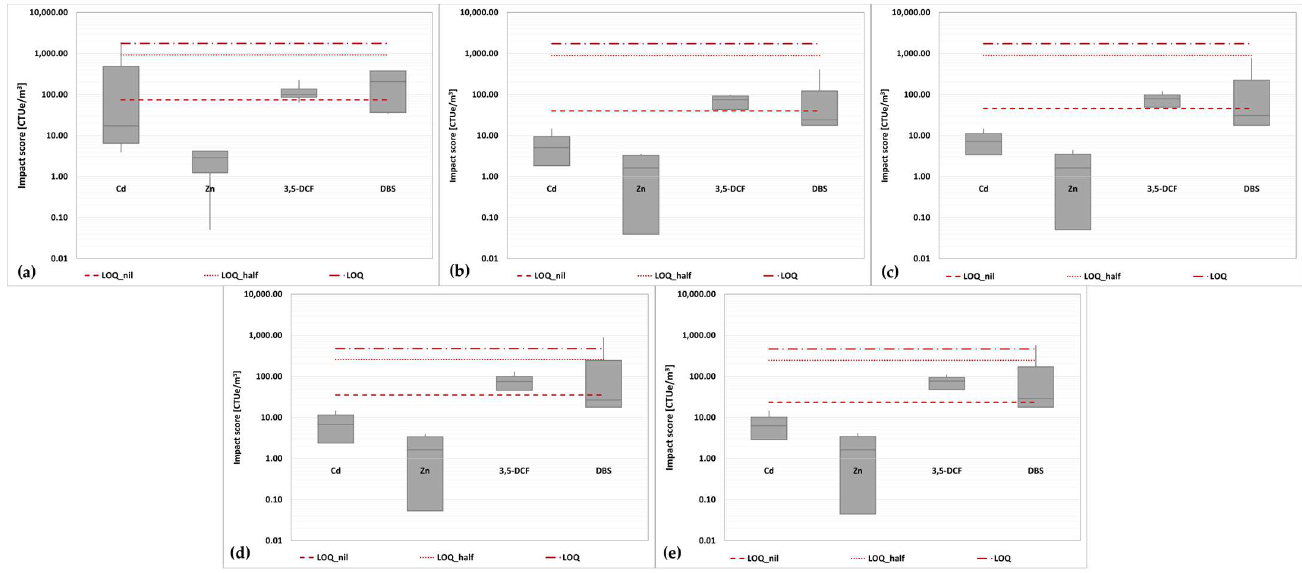
Figure 5. ( a ) WWTP A; ( b ) WWTP B, routine time; ( c ) WWTP B, harvest time; ( d ) WWTP C, CAS; ( e ) WWTP C, MBR: box plot of the impact scores obtained from the four baseline toxicity assays ( D.